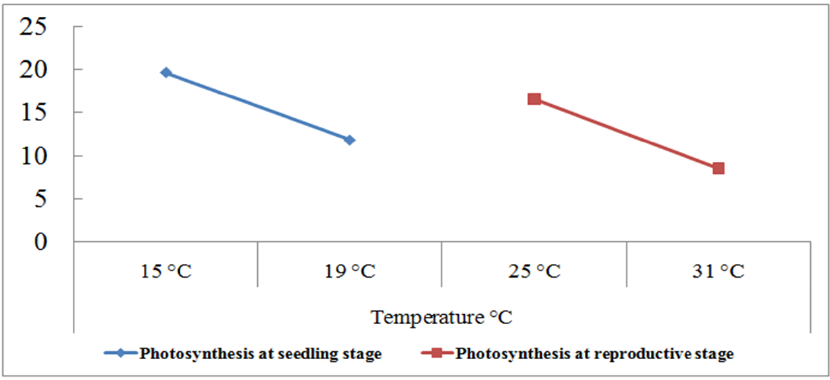
Figure 4. Photosynthetic (µmol m − 2 s − 1 ) response of 180 wheat genotypes with the grain yield per plant (g) at the seedling and reproductive stages. Data collected under normal and heat stress (4–5 °C above normal) conditions [94].